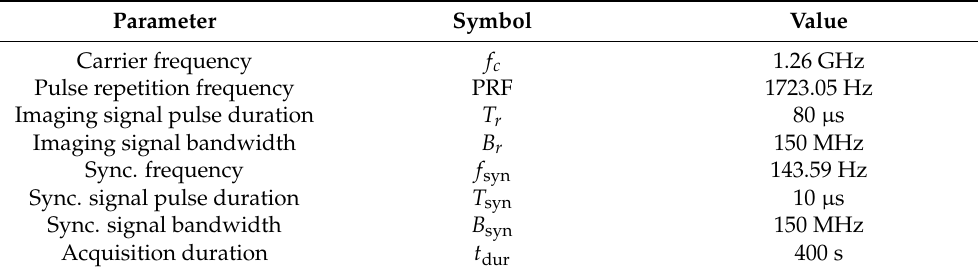
Table 1. System parameters of ground validation